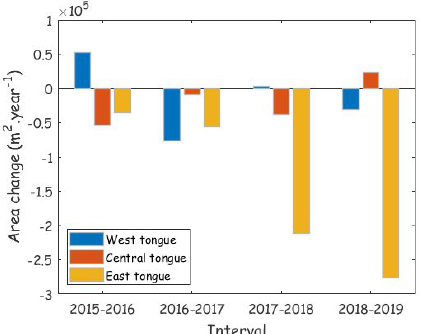
Figure 6. Contribution of each tongue for Grey Glacier’s area change in the ice front.